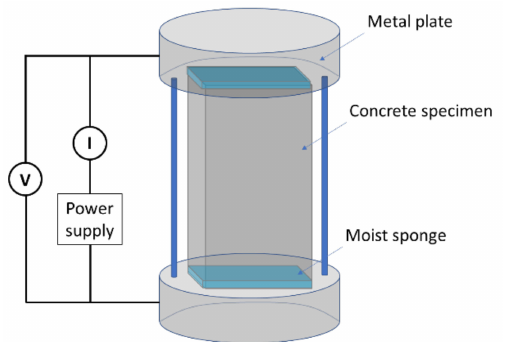
Figure 1. Uniaxial method (please note that electric current is measured in series to the power supply, whereas the corresponding potential drop is measured in